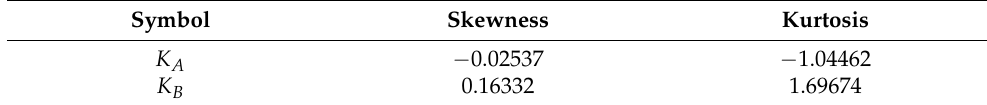
Table 5. Normal distribution checklist.